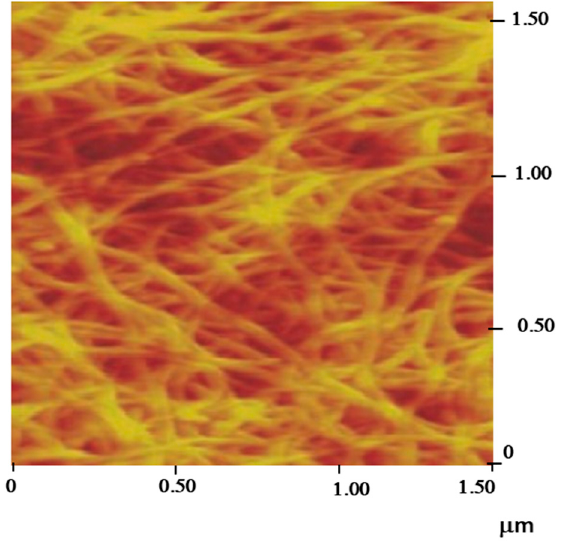
Figure 2. Atomic Force Microscopy image of a Single-walled carbon nanotube transferred film surface.